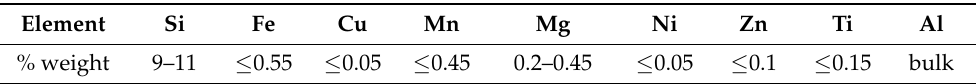
Table 1. Nominal chemical composition of the AlSi10Mg powder for the laser powder bed fusion (LPBF)